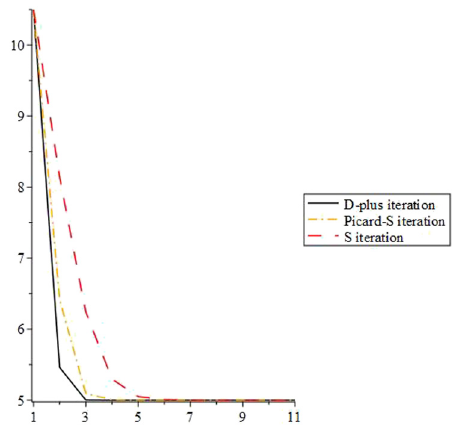
Figure 4: Convergence of D - plus iteration process when initial guess is −5.5 .